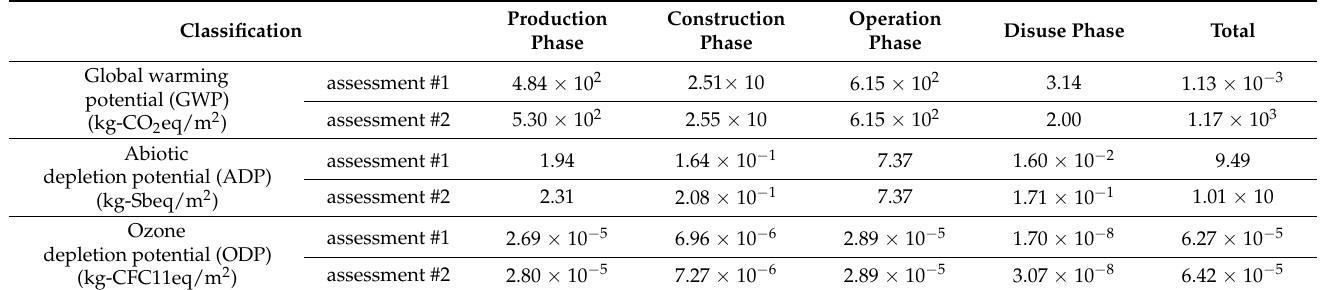
Table 6. Case study results of all phases of the building’s life cycle.